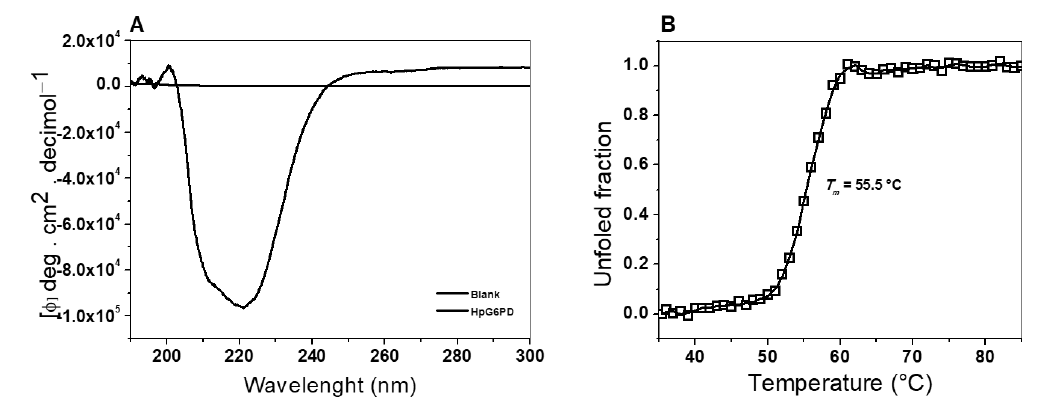
Figure 5. Circular dichroism assay (CD) and thermal stability assessment of the HpG6PD enzyme. ( A ) The far-UV circular dichroism spectrum of HpG6PD in its native state. ( B ) Analysis of thermal stability via CD. CD monitored the changes in the signal at 222 nm, as the temperature increased from 35 °C to 85 °C. In both experiments, the HpG6PD protein was incubated at 0.5 mg/mL in 25 mM phosphate buffer (pH 7.4). Both experiments are representative of three independent experiments.